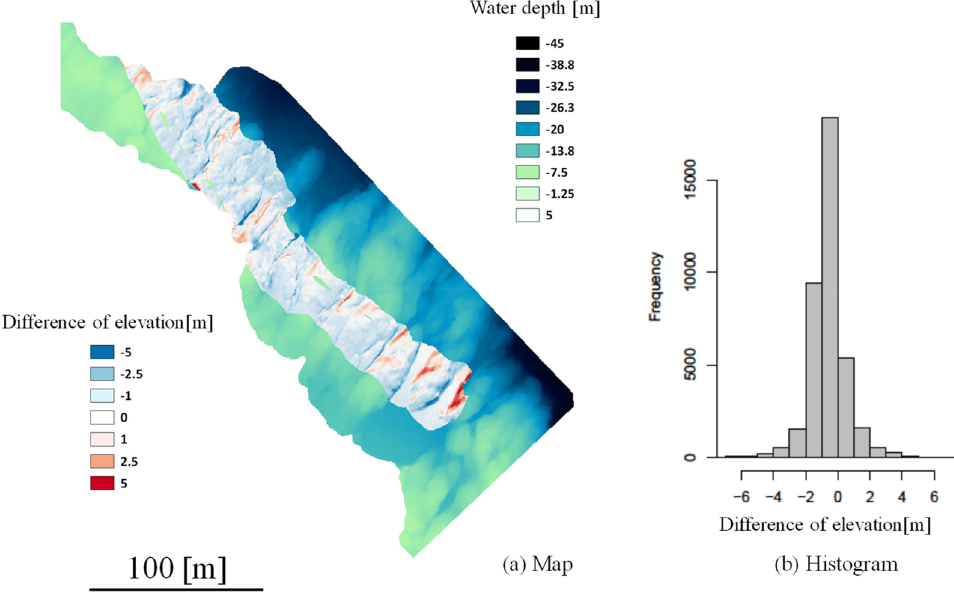
Figure 5. Left: distribution map of the elevation difference. Right: histogram of the elevation difference at the pixel